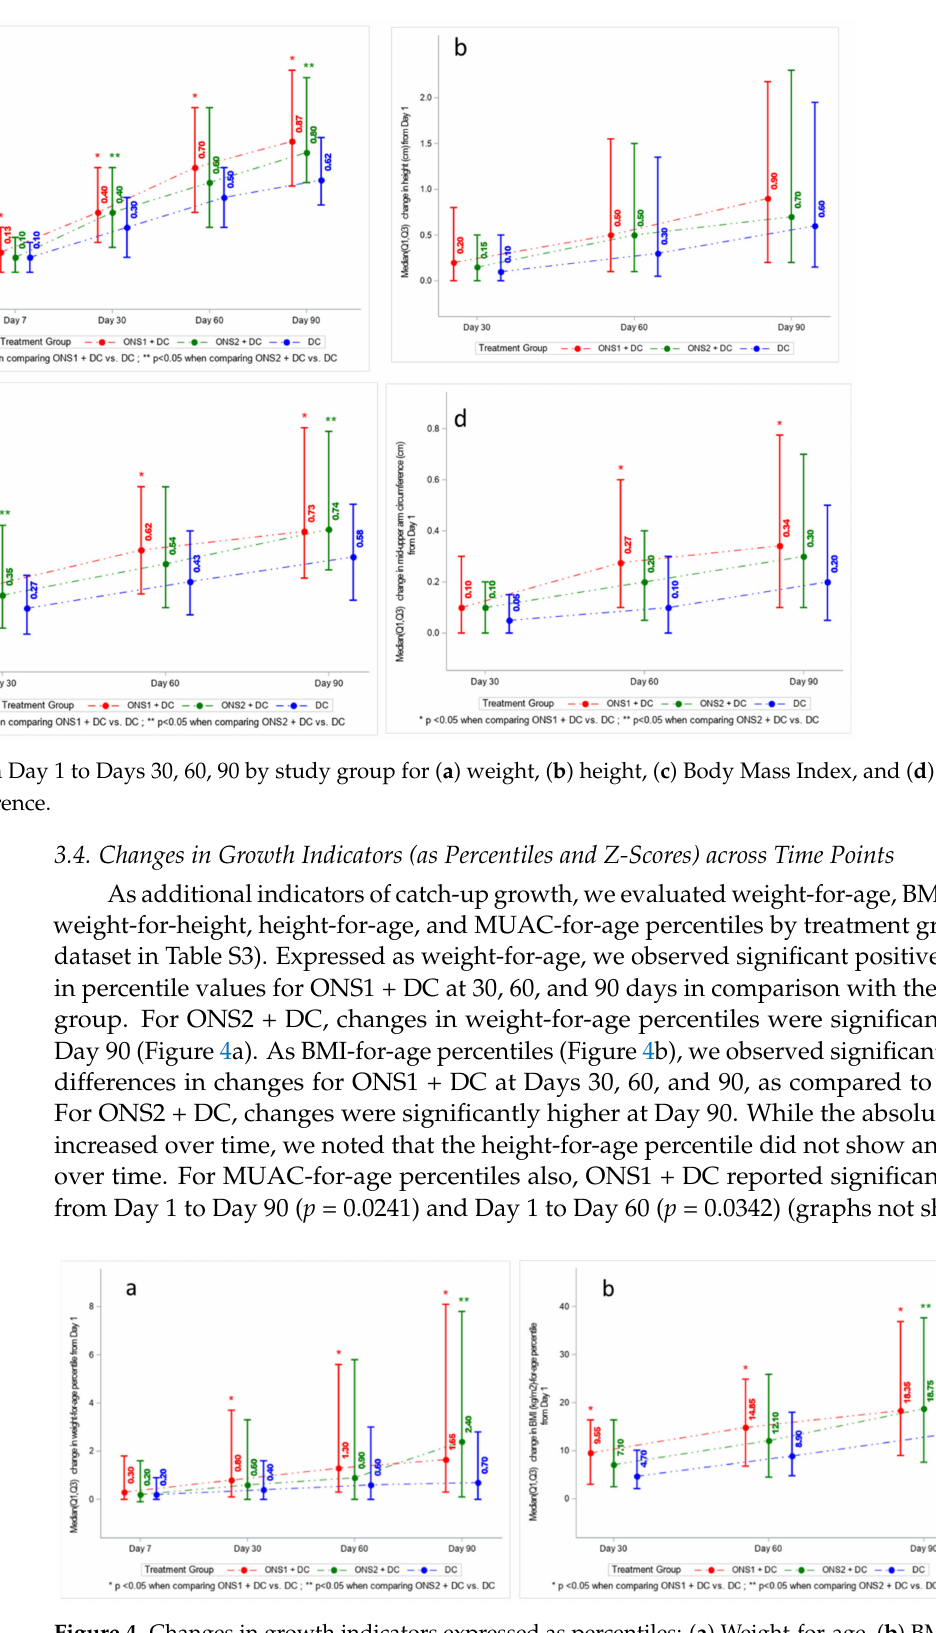
Figure 4. Changes in growth indicators expressed as percentiles: ( a ) Weight-for-age, ( b )